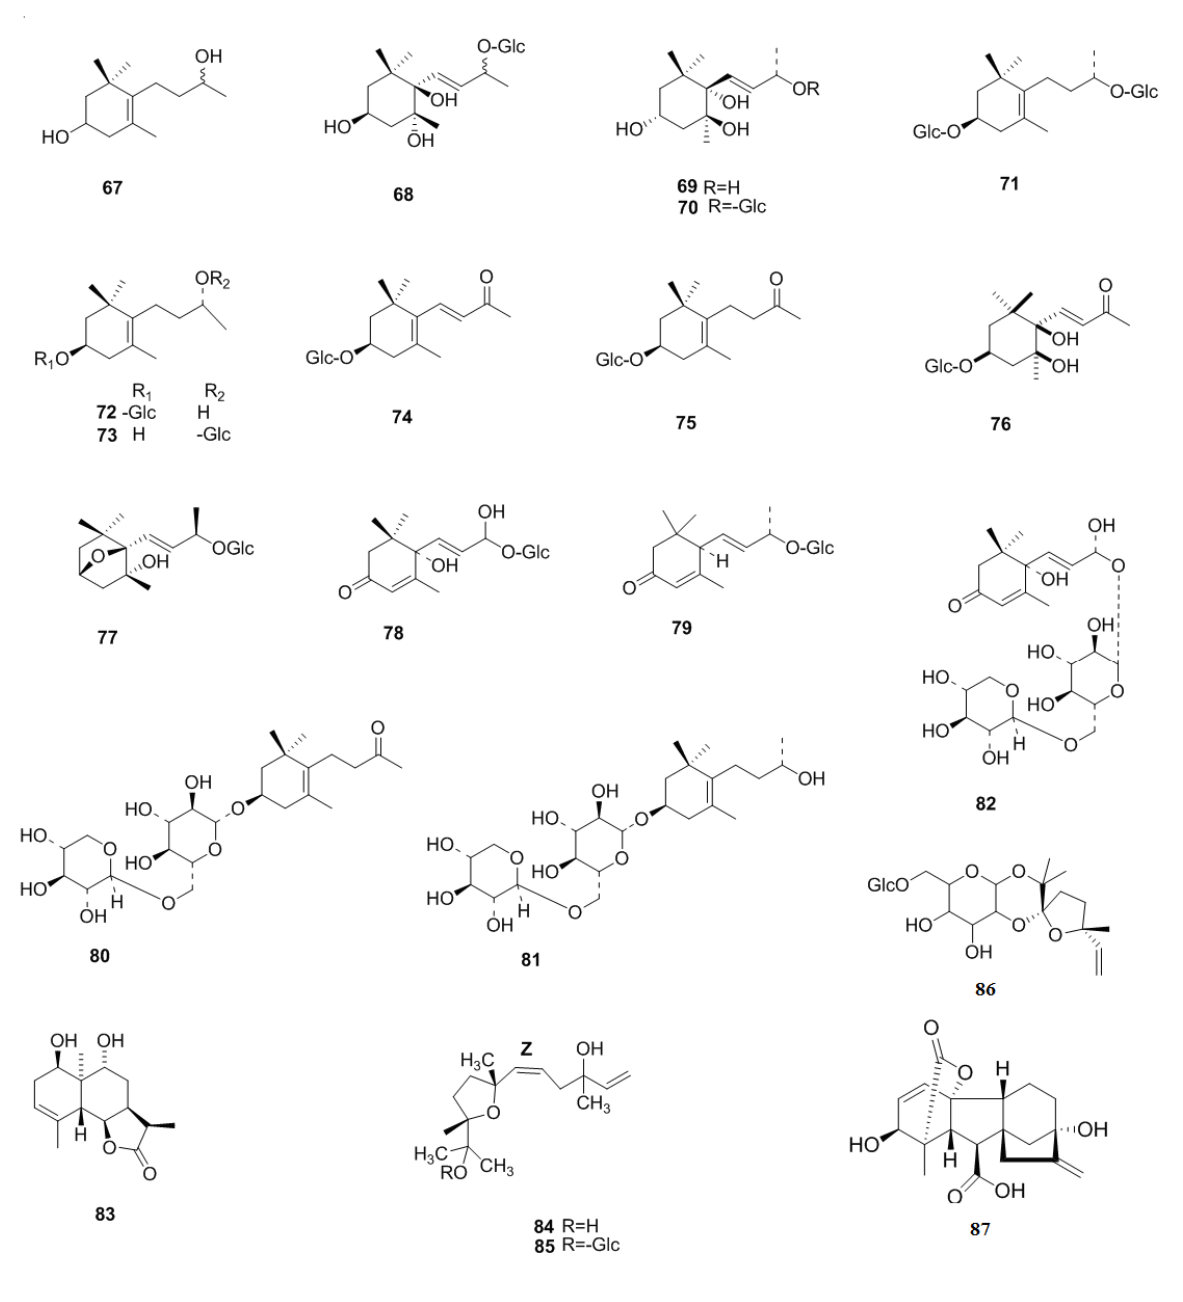
Figure 7. Chemical structures of monoterpenoids and sesquiterpenoids in C. pinnatifida